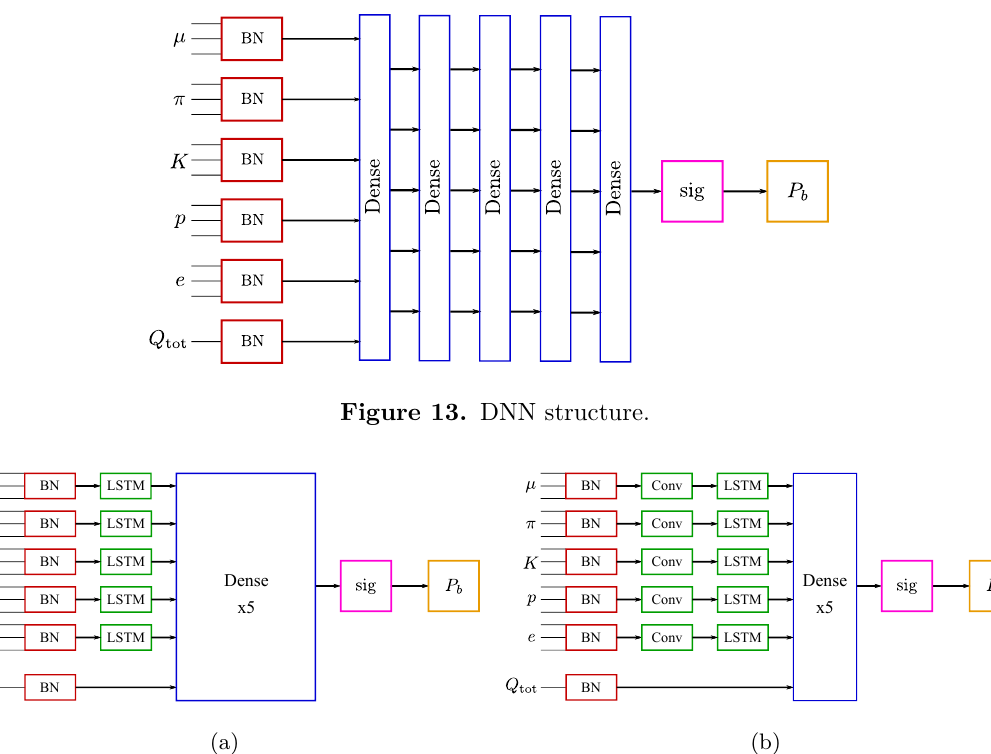
Figure 14. DNN structure for (a) the “LSTM” model and for (b) the “LSTM+CONV”